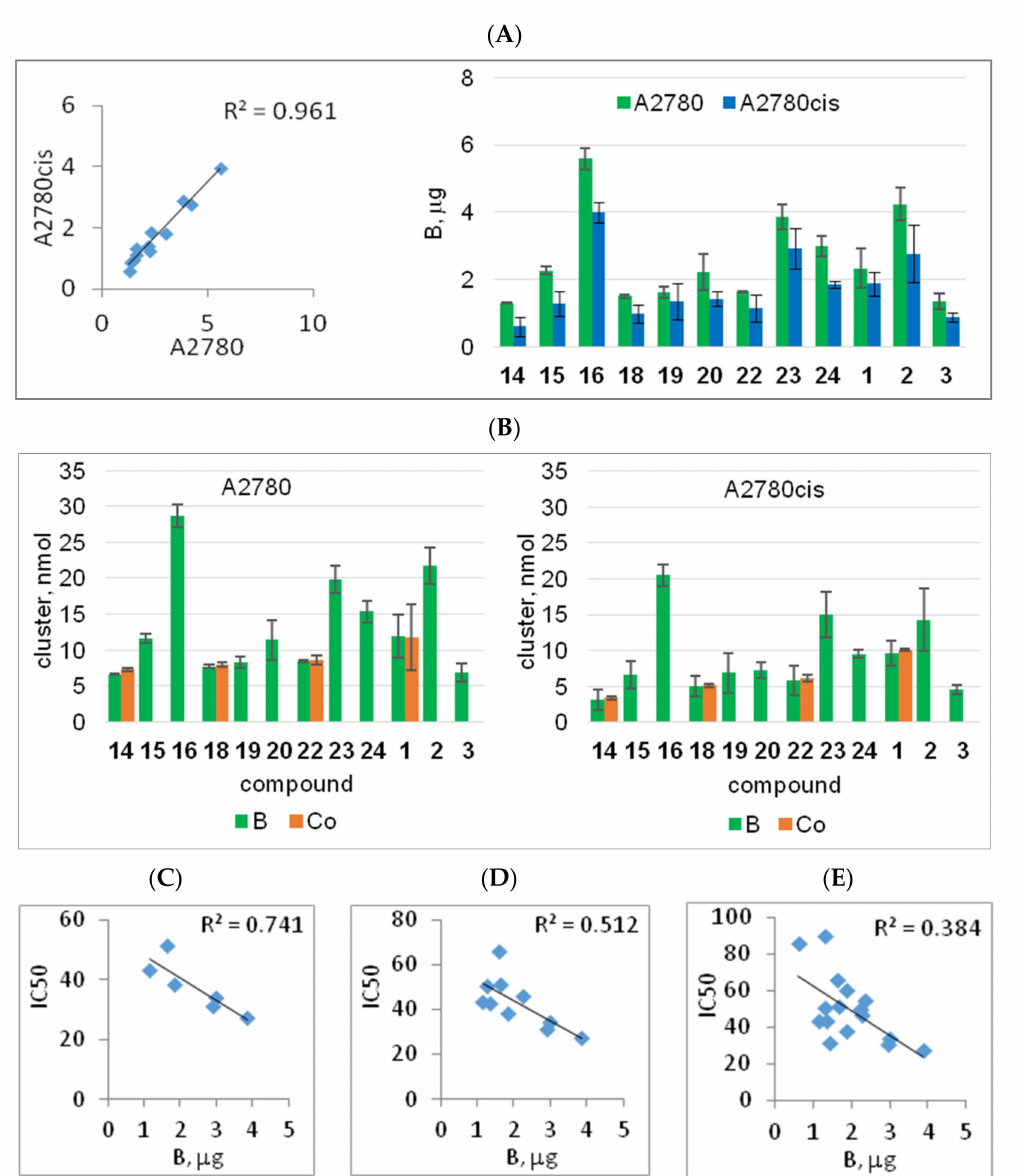
Figure 4. Incorporation of metalla bis(dicarbollide)-modified adenine nucleosides into A2780 and A2780cis cells ( A , B ) and its relationship to the cytotoxicity of the compounds ( C – E ). The amount of boron-bearing compounds in the cells was determined using ICP-MS, and it was expressed as µ g B per 10 6 cells ( A ) and nmol of compound per 10 6 cells ( B ); the amount of the compounds was calculated for the B-containing metalla bis(dicarbollide) cluster [M(III)(1,2-C 2 B 9 H 11 ) 2 ]. Accumulation of Co-containing compounds ( 14 , 18 , 22 , and 1 ) was also determined based on Co content for comparison (orange bars). ( C – E ) Boron content in A2780cis cells in relation to compound cytotoxicity (IC50, µ M); a stepwise analysis: C2 (cid:48) derivatives (R 2 = 0.741, p = 0.028, ( C )); C2 (cid:48) derivatives and compounds with Fe ions (R 2 = 0.512, p = 0.020, ( D )); all compounds 14 , 20 , and 1 (R 2 = 0.384, p = 0.010, ( E )); R 2 , Pearson correlation coefficient